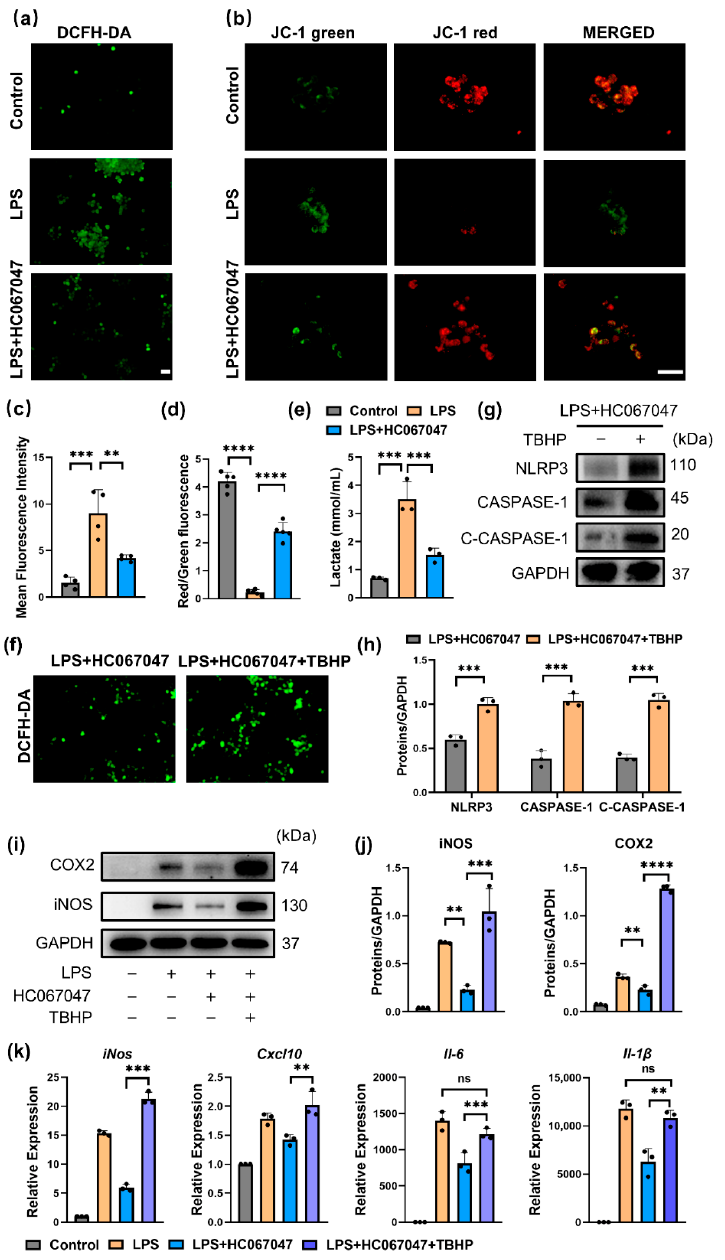
Figure 6. TRPV4 blockade inhibited NLRP3 via mitochondrial ROS. ( a ) DCFH-DA fluorescence of mitochondrial ROS in 100 ng/mL LPS-treated cells with 10 µ mol/L HC067047 for 6 h (Scale bar: 50 µ